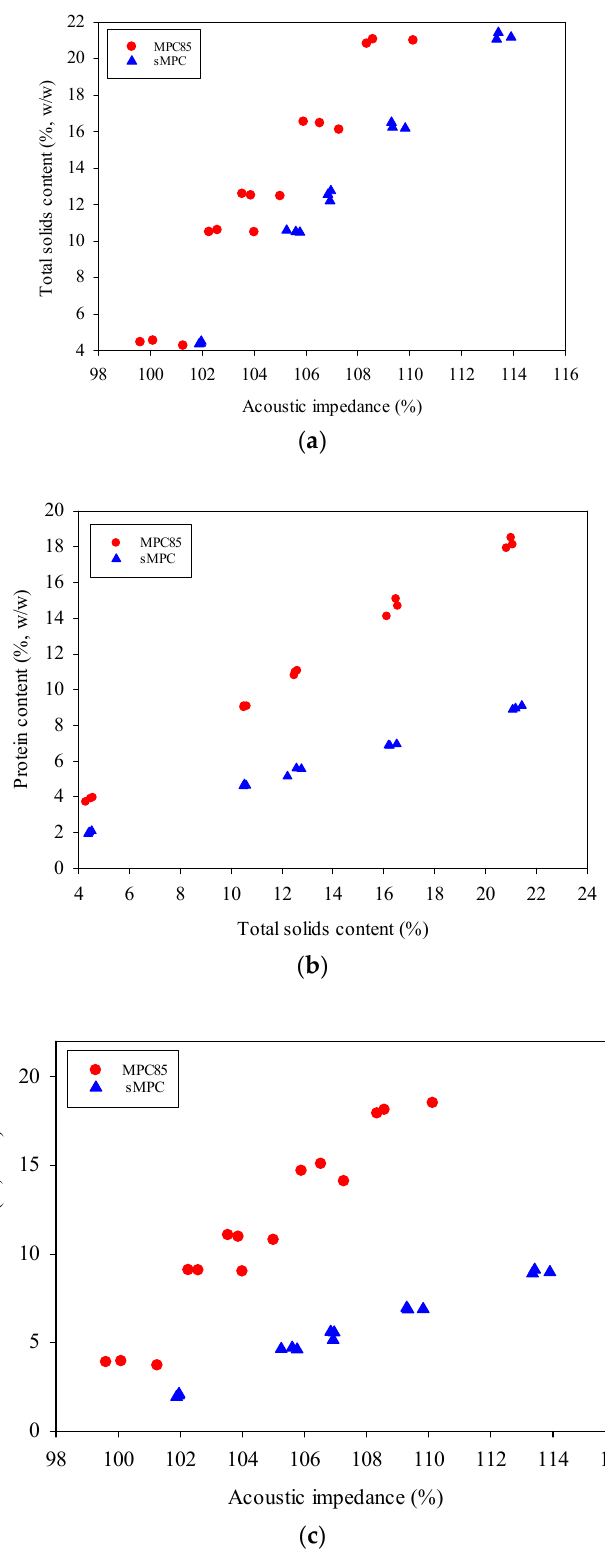
Figure 5. ( a ) TS content (4 – 21% TS) versus AI of MPC85 (●) and sMPC ( ▲ ) samples. ( b ) Protein versus TS content (4 – 21% TS) of MPC85 and sMPC samples. ( c ) Protein versus AI of MPC85 and sMPC samples.